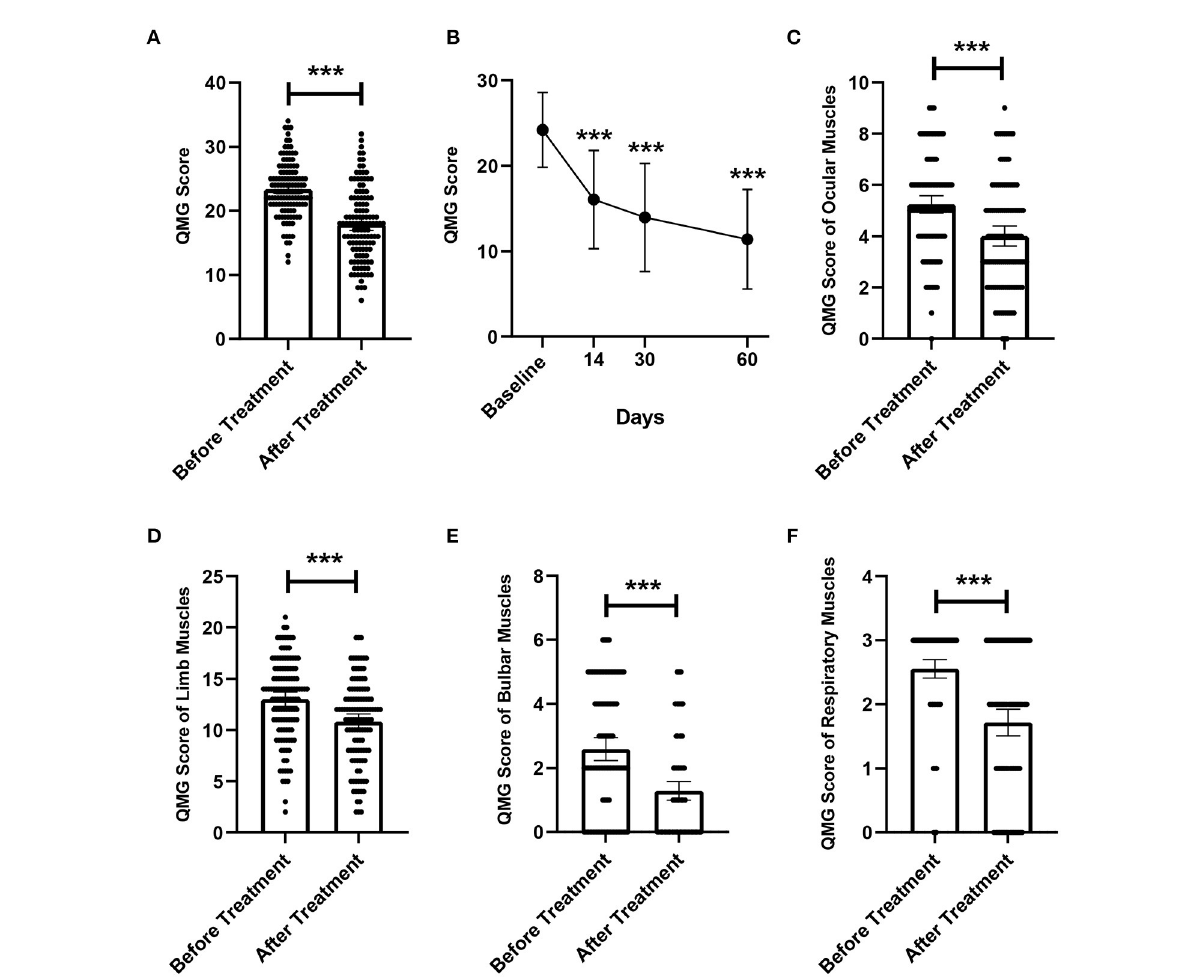
FIGURE2 Changes in QMGS before and after treatment. (A) Changes in overall QMGS before and after treatment. (B) Changes in QMGS of patients before treatment, 14, 30, and 60 days after treatment completion. (C) Changes in QMGS of ocular muscles before and after treatment. (D) Changes in QMGS of limb muscles before and after treatment. (E) Changes in QMGS of bulbar muscles before and after treatment. (F) Changes in QMGS of respiratory muscles before and after treatment. *** p <